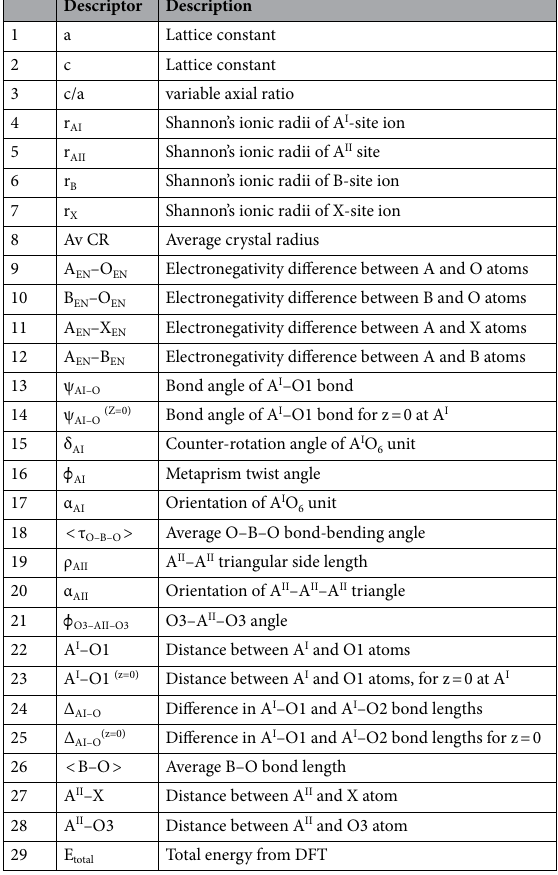
Table 1. Descriptor set for apatite systems, with the corresponding descriptions. We have defined a descriptor set encompassing atoms, bonds, and crystallographic measures of the apatite structure. The descriptors are from the geometrical parameterization scheme of Mercier et al. 18,19 , as well as descriptors from Shannon 20 and Pauling 21 . In that work, they quantified the bond distortions based on algebraically independent bond lengths and angles. From this data, we want to track the relationship between geometrical parameters and